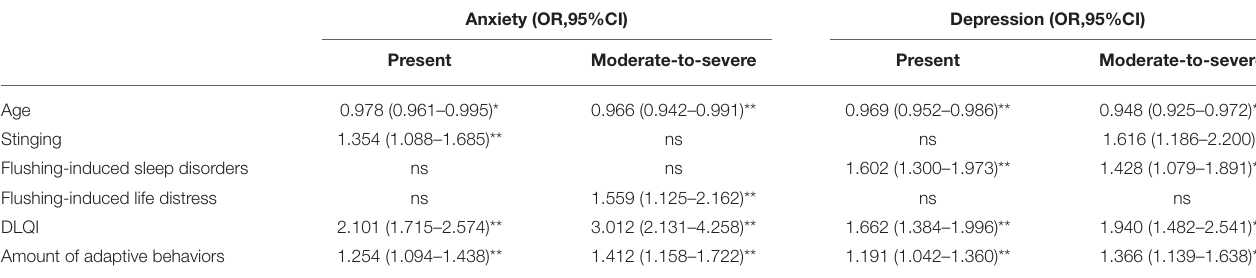
TABLE 5 | Predictors of anxiety or depression identified by multivariate logistic